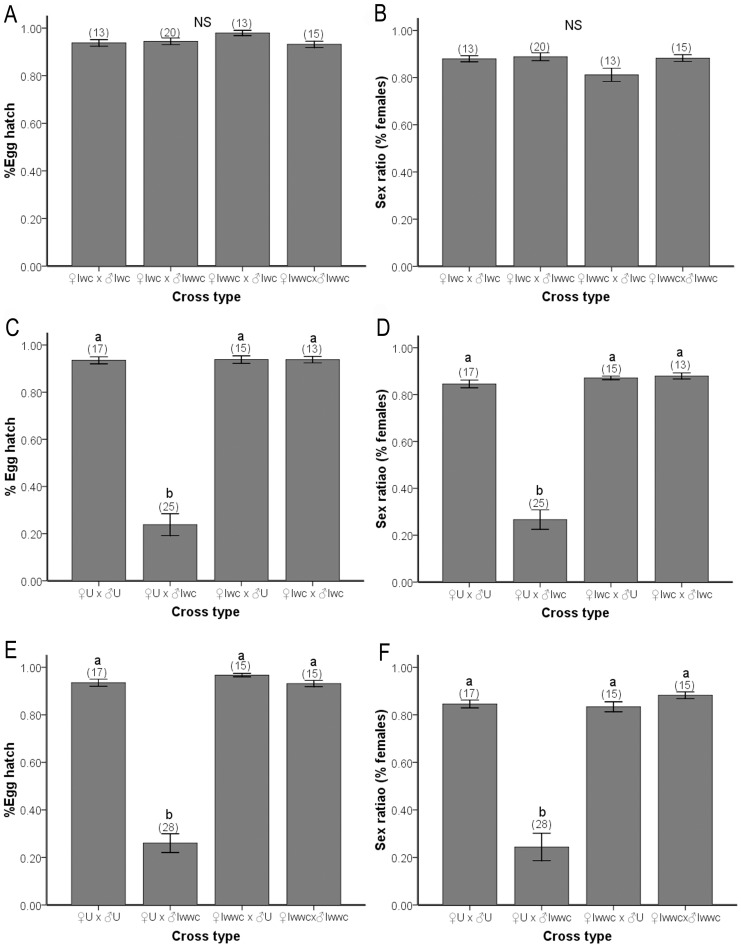
CI resulting from crosses of the uninfected, double-infected and multiple-infected strains.Results are mean percent embryo hatch ±SEM and sex ratio ±SEM. Number of replicates for each of the nine cross types are shown in parentheses. a and b represent statistic groups (Tukey-HSD test, p<0.05); NS, not significant at the 5% level.